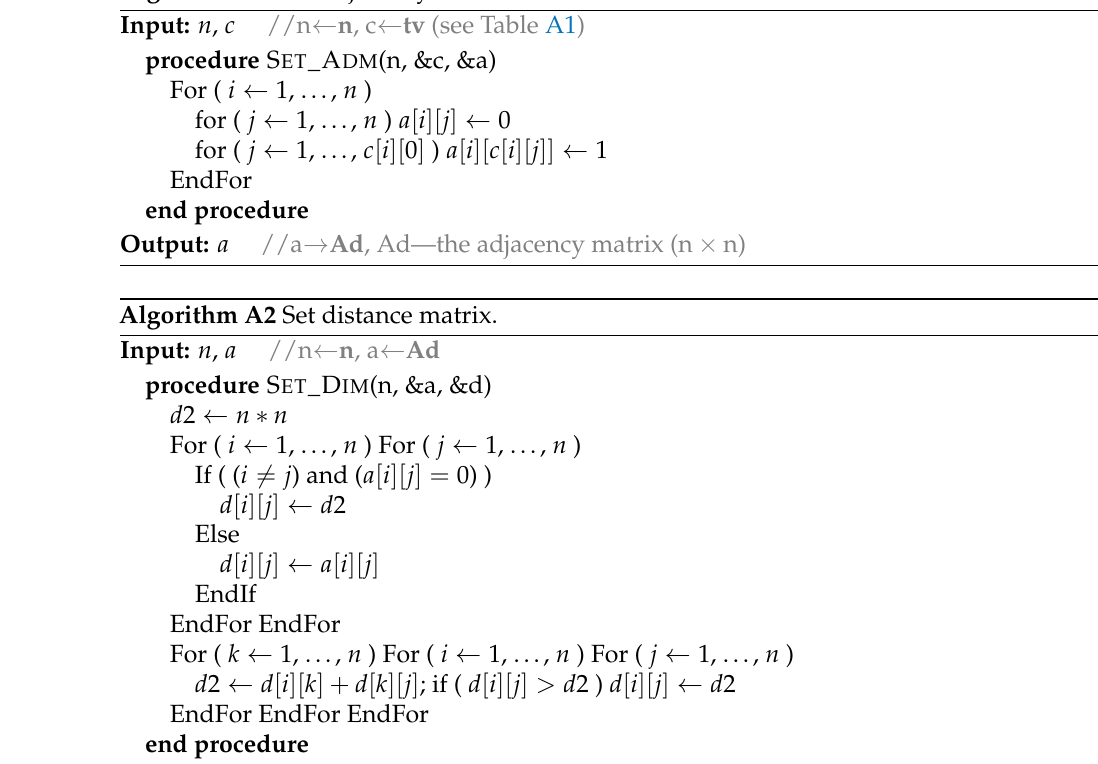
Algorithm A1 Set adjacency matrix.